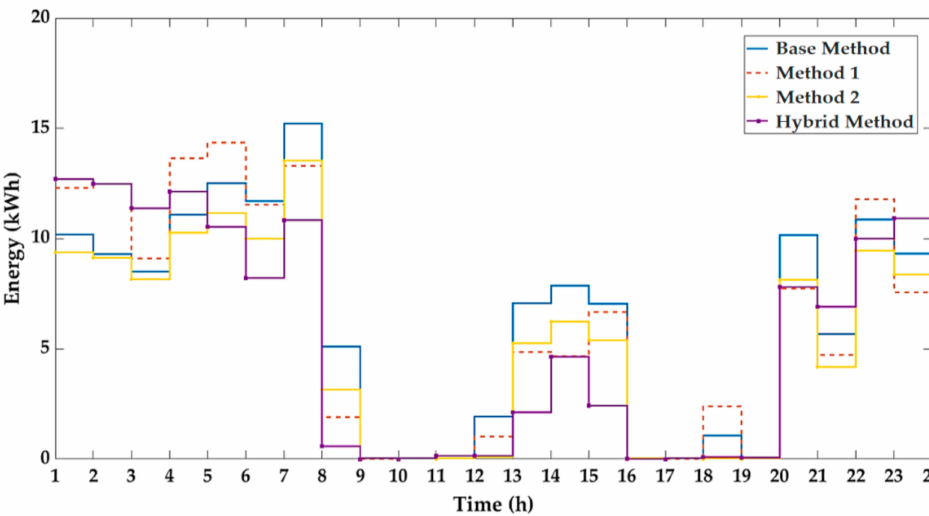
Figure 9. Comparison of optimal purchased